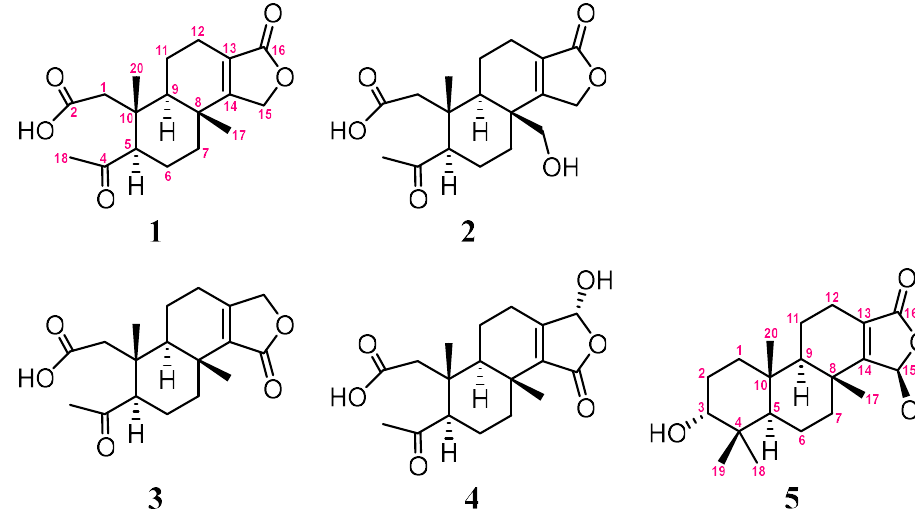
Figure 1. Structures of metabolites 1 – 5 .